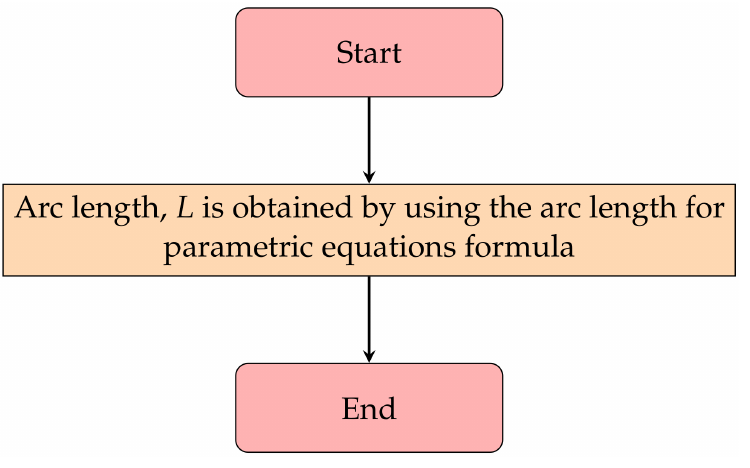
Figure 5. Flowchart for obtaining the arc length of the